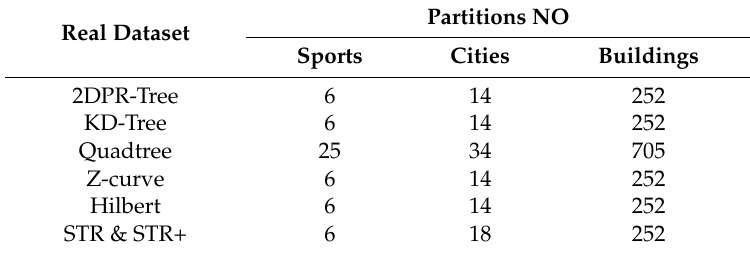
Table 5. Partition number generated by indexing techniques in the real datasets.